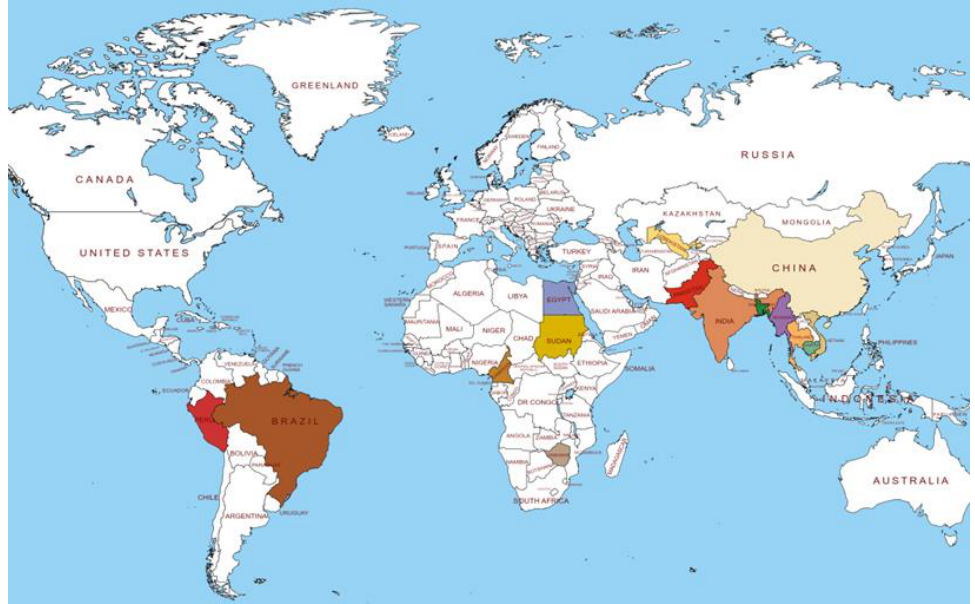
Figure 1. Jute-producing countries in the world .